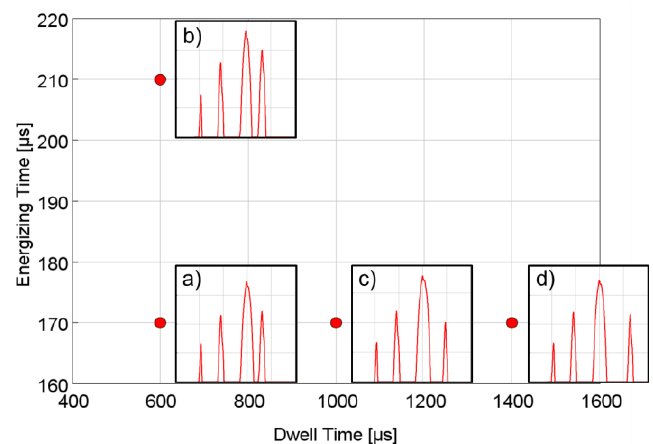
Figure 14. Injection schedules varying the ET and the DT of post injection, WP: 1500 rpm × 5.0 bar BMEP.